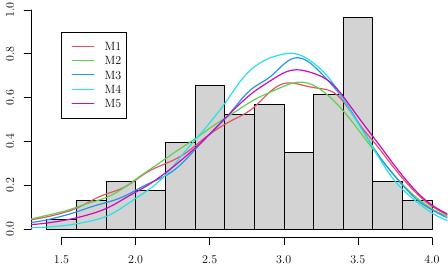
Figure 8 – Histogram of the Canadian lynx time series and the non-parametric kernel density estimation of 10000-length simulated trajectories from the TAR models M1 – M5.